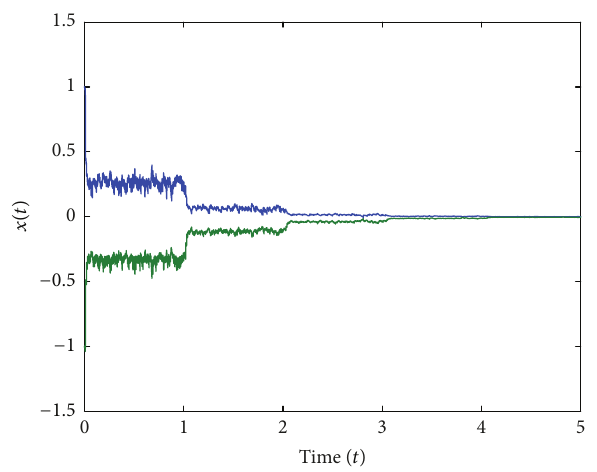
Figure 3: The solution of system (47) with impulses (single sample).